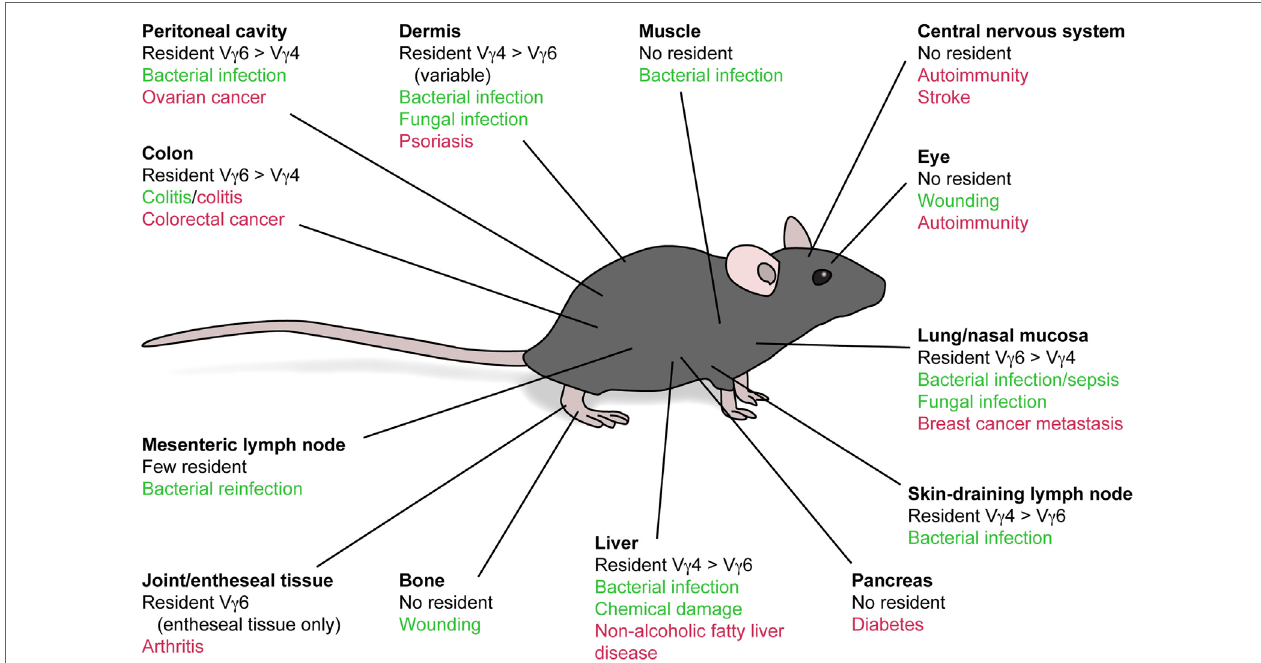
FigURe 1 | Beneficial and detrimental functions of local and infiltrating γδ T17 cells. V γ 4 + and V γ 6 + γδ T17 cells distribute to numerous peripheral tissues following development, although with differential bias. These cells are implicated in beneficial (green) and detrimental (red) immune responses both in these tissues and those that do not evidently harbor a resident γδ T17 cell population. This suggests that migratory behavior of γδ T17 cells, particularly during autoimmune conditions, exerts a strong influence on the outcome of